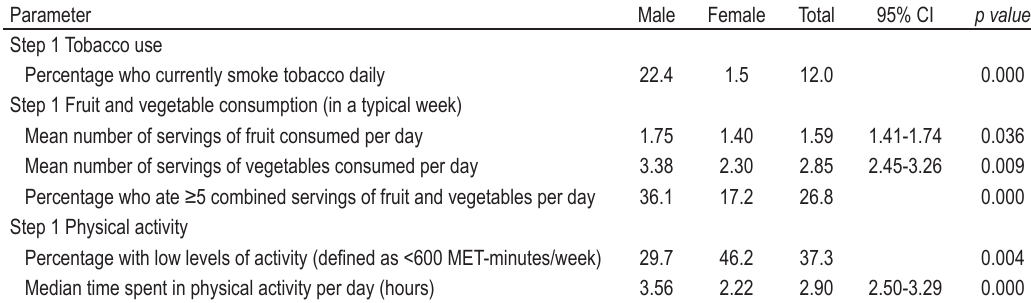
TABLE 2. Summary of results from step 1 WHO STEPS approach studying risk factors of NCDs n (%) Parameter